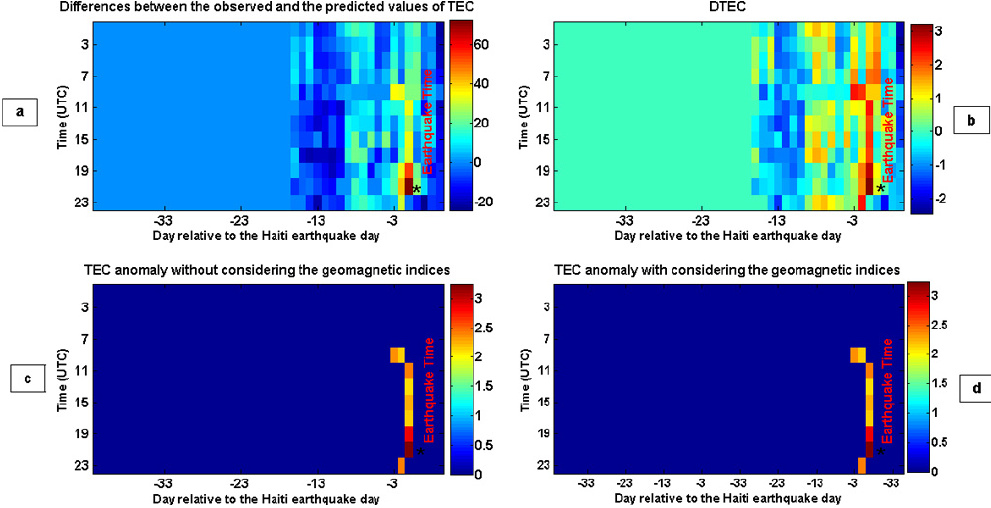
difference values are detected at 20:00 and 22:00 UTC 1 day before the event (Fig. 8a and b). In Fig. 8c anomalous TEC values are only depicted at times when | DTEC | > 1 . 5. The TEC value exceeds the higher bound ( µ ± 1 . 5 × σ) 1 day prior to the earthquake at 20:00 UTC with the value of 44 % of the higher bound. It had also reached to its maximum value (i.e.,